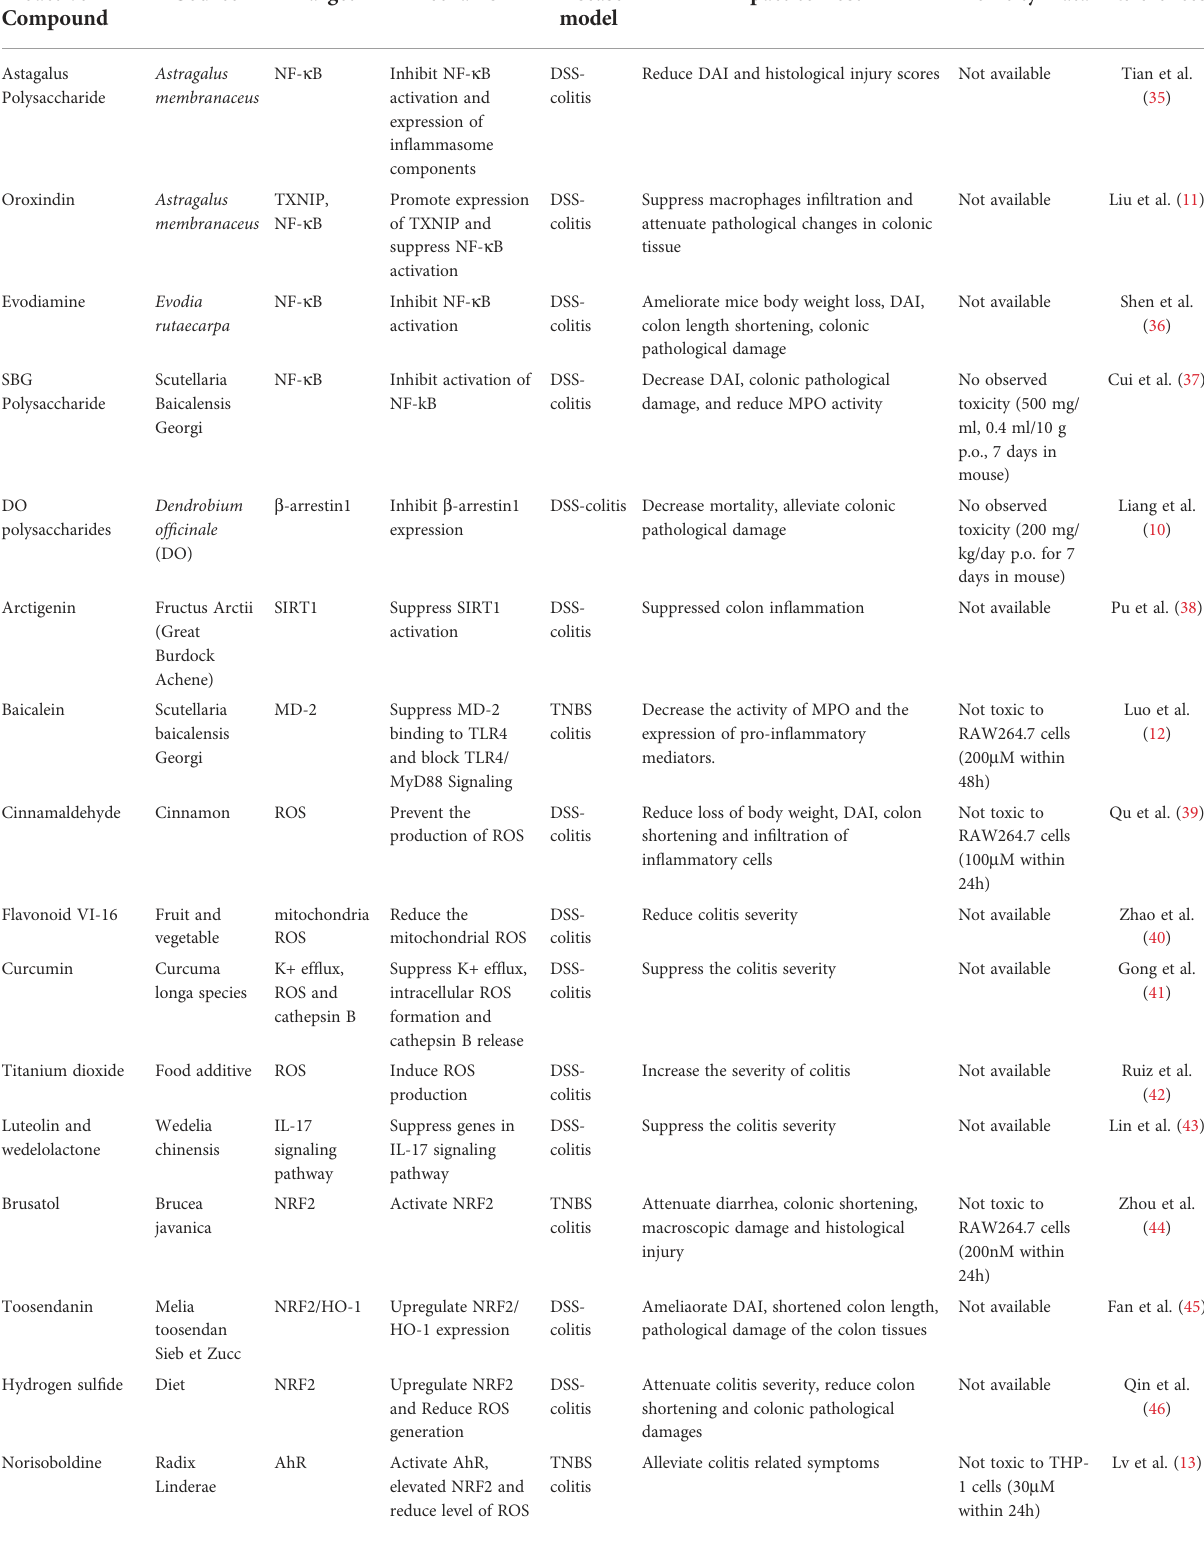
TABLE 1 Summary of Natural Compounds that Regulates In fl ammasomes in Colitis